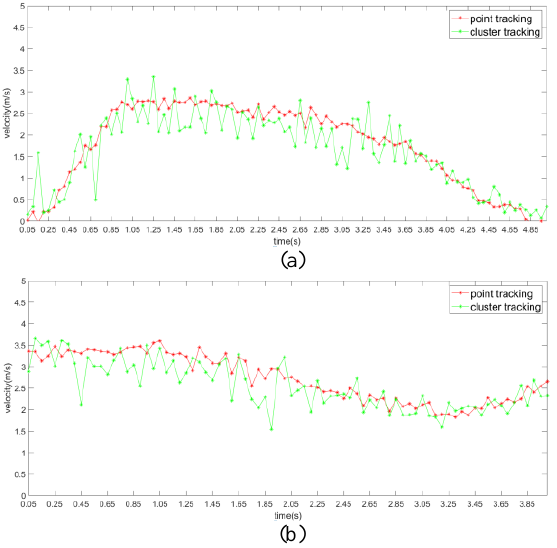
Figure 12. Comparison between point and cluster tracking results.